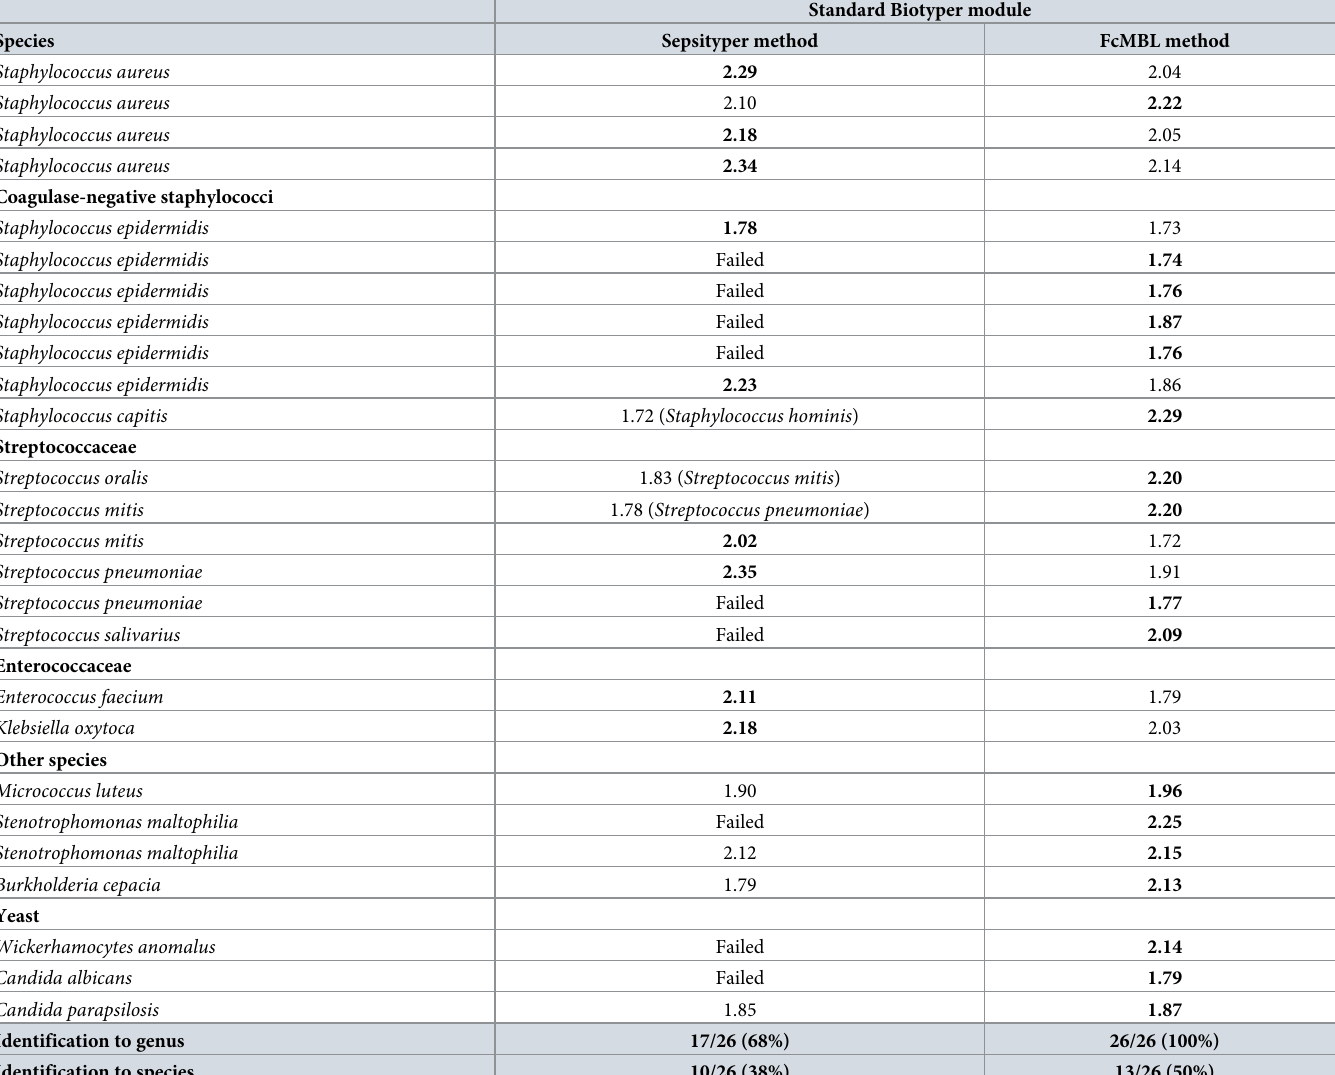
Table 2. Bruker Biotyper log score comparison of the Sepsityper 1 and FcMBL methods for the detection of pathogens in positive clinical blood culture samples. Bold Log scores indicate the higher score of the two